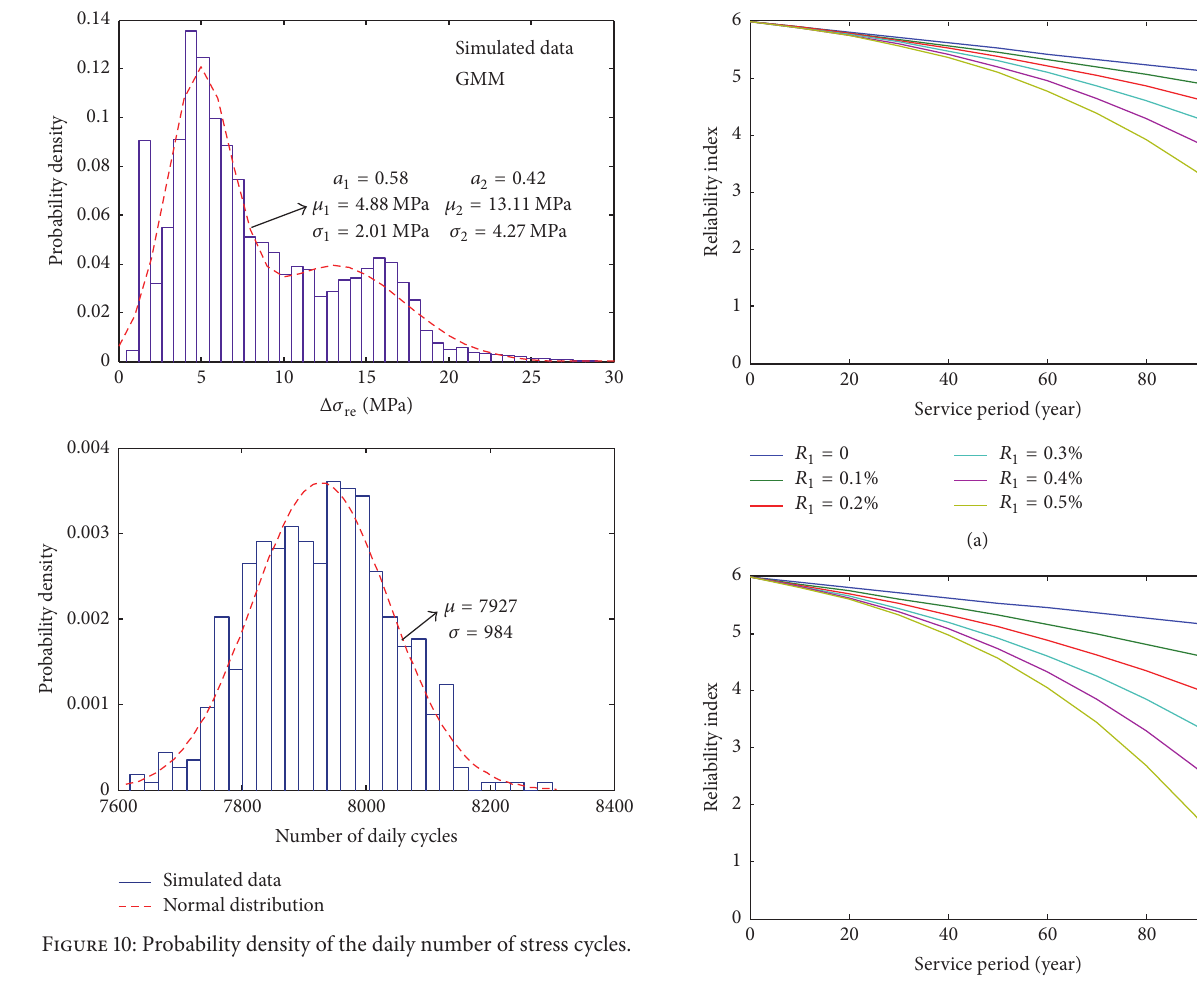
𝑅 2 indicates the Figure 11: Fatigue reliability index of the rib-to-deck joint: (a) growth rate of ADTT and (b) growth rate of